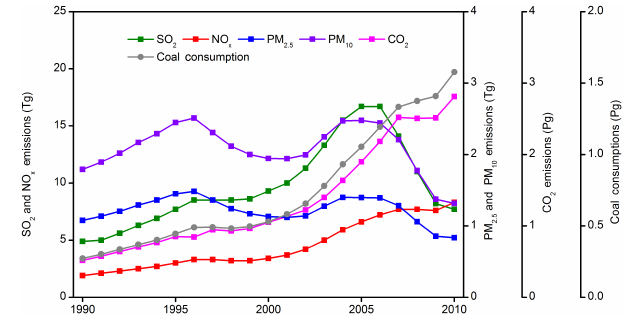
Figure 4. Coal consumption and emissions of SO 2 , NO x , PM 2 . 5 , PM 10 , and CO 2 of coal-fired power plants in China from 1990 to